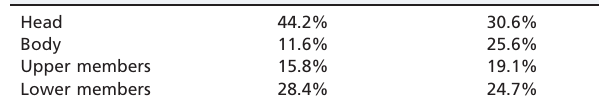
Table 1 - Features of facial fractures occurrences in motorvehicle accidents according to data from a large Sa˜o Paulo hospital (2007). 21 Number of patients